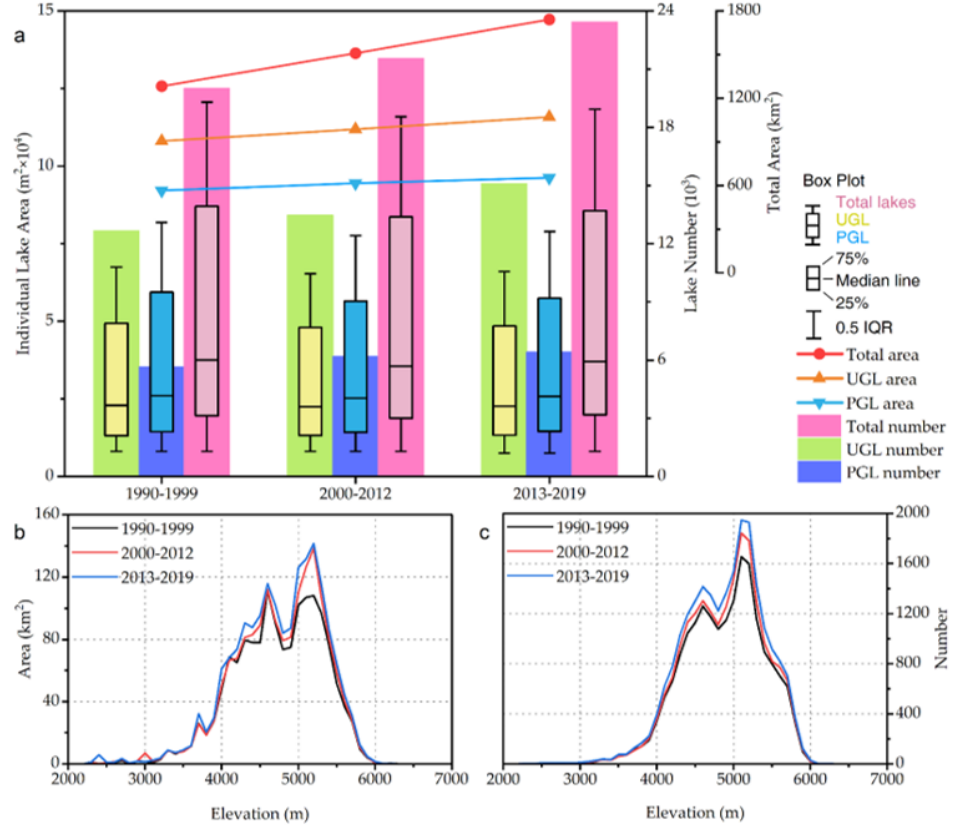
Figure 5. ( a ) Numbers and areas with three periods of all glacial lakes and PGL, UGL; ( b ) altitudinal distribution (100 m bin sizes) of lake areas; ( c ) altitudinal distribution (100 m bin sizes) of lake numbers.